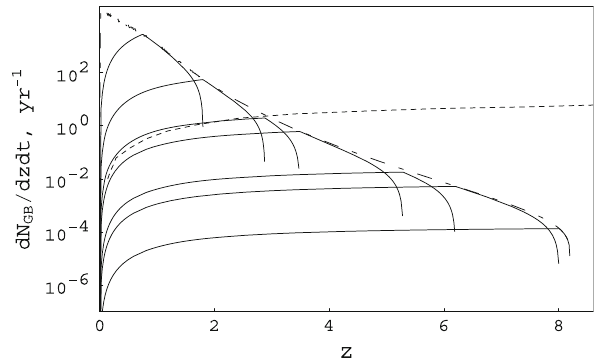
Fig. 10 Gravitational bursts distribution by sources (PBHs clusters) red-shifts z . The solid curves correspond to the total merger rates for the PBHs in the mass intervals M = 10 2 − 5 × 10 2 M (cid:2) , 5 × 10 2 − 10 3 M (cid:2) , 10 3 − 5 × 10 3 M (cid:2) , 5 × 10 3 − 10 4 M (cid:2) , 10 4 − 5 × 10 4 M (cid:2) , and 5 × 10 4 − 10 5 M (cid:2) (from up to down). The breaks on the curves correspond to the maximum red-shifts of LISA detection in these inter- vals. Envelope bar-dotted curve shows the total rate. For comparison the dashed line shows the result of